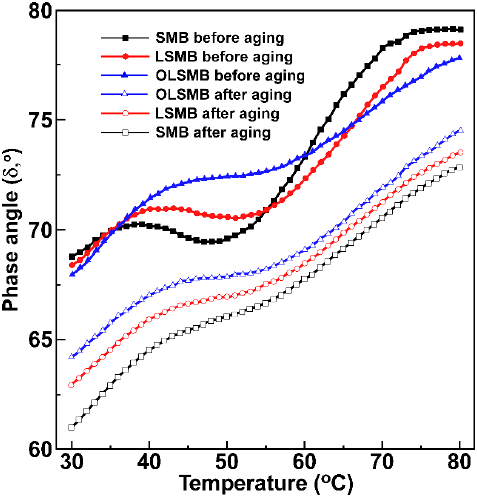
Figure 6. Phase angle of SMB, LSMB and OLSMB at a medium and high temperature before and after aging.